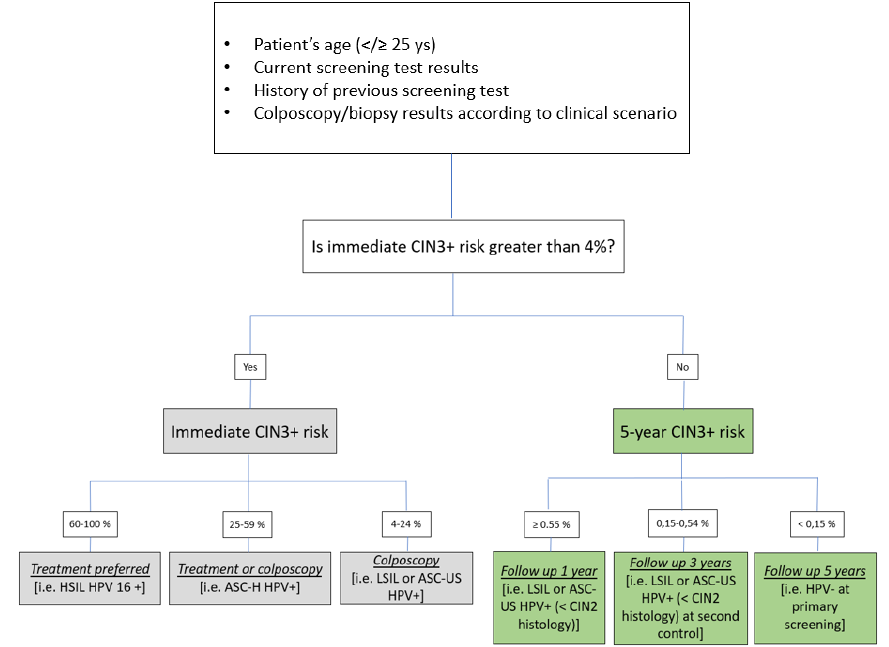
Figure 1. Management proposal based on patient risk of HSIL (CIN3+) stratification (16, 23).